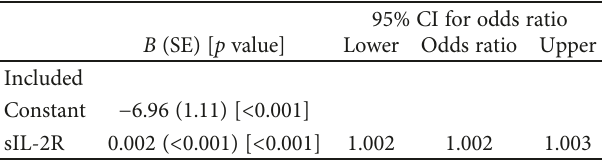
Table 2: Results of the binary logistic regression